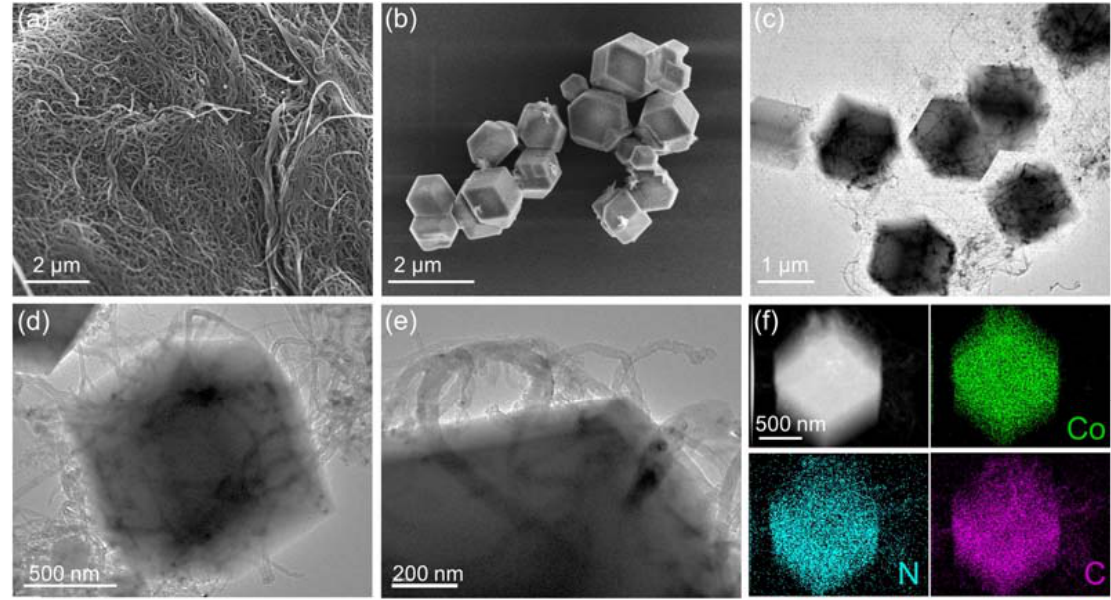
Figure 3. SEM images of ( a ) CNTs and ( b ) ZIF ‐ 67; ( c – e ) TEM images of ZIF ‐ 67@CNTs, ( f ) HADDF ‐ STEM image, and corresponding EDS elements mapping profiles of ZIF ‐ 67@CNTs.